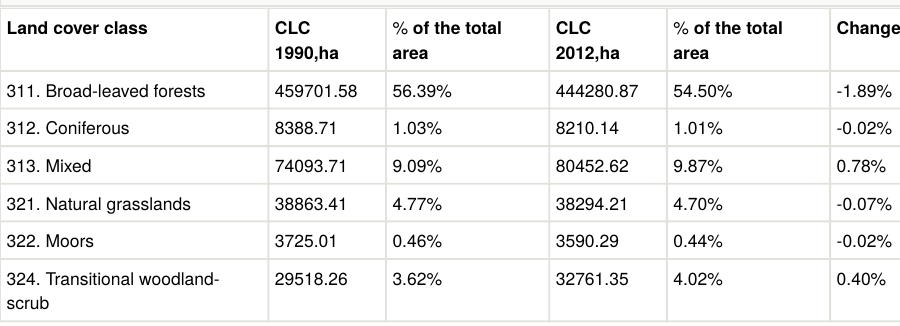
Changes in the area of the land cover classes occupied by forest vegetation for Central Balkan